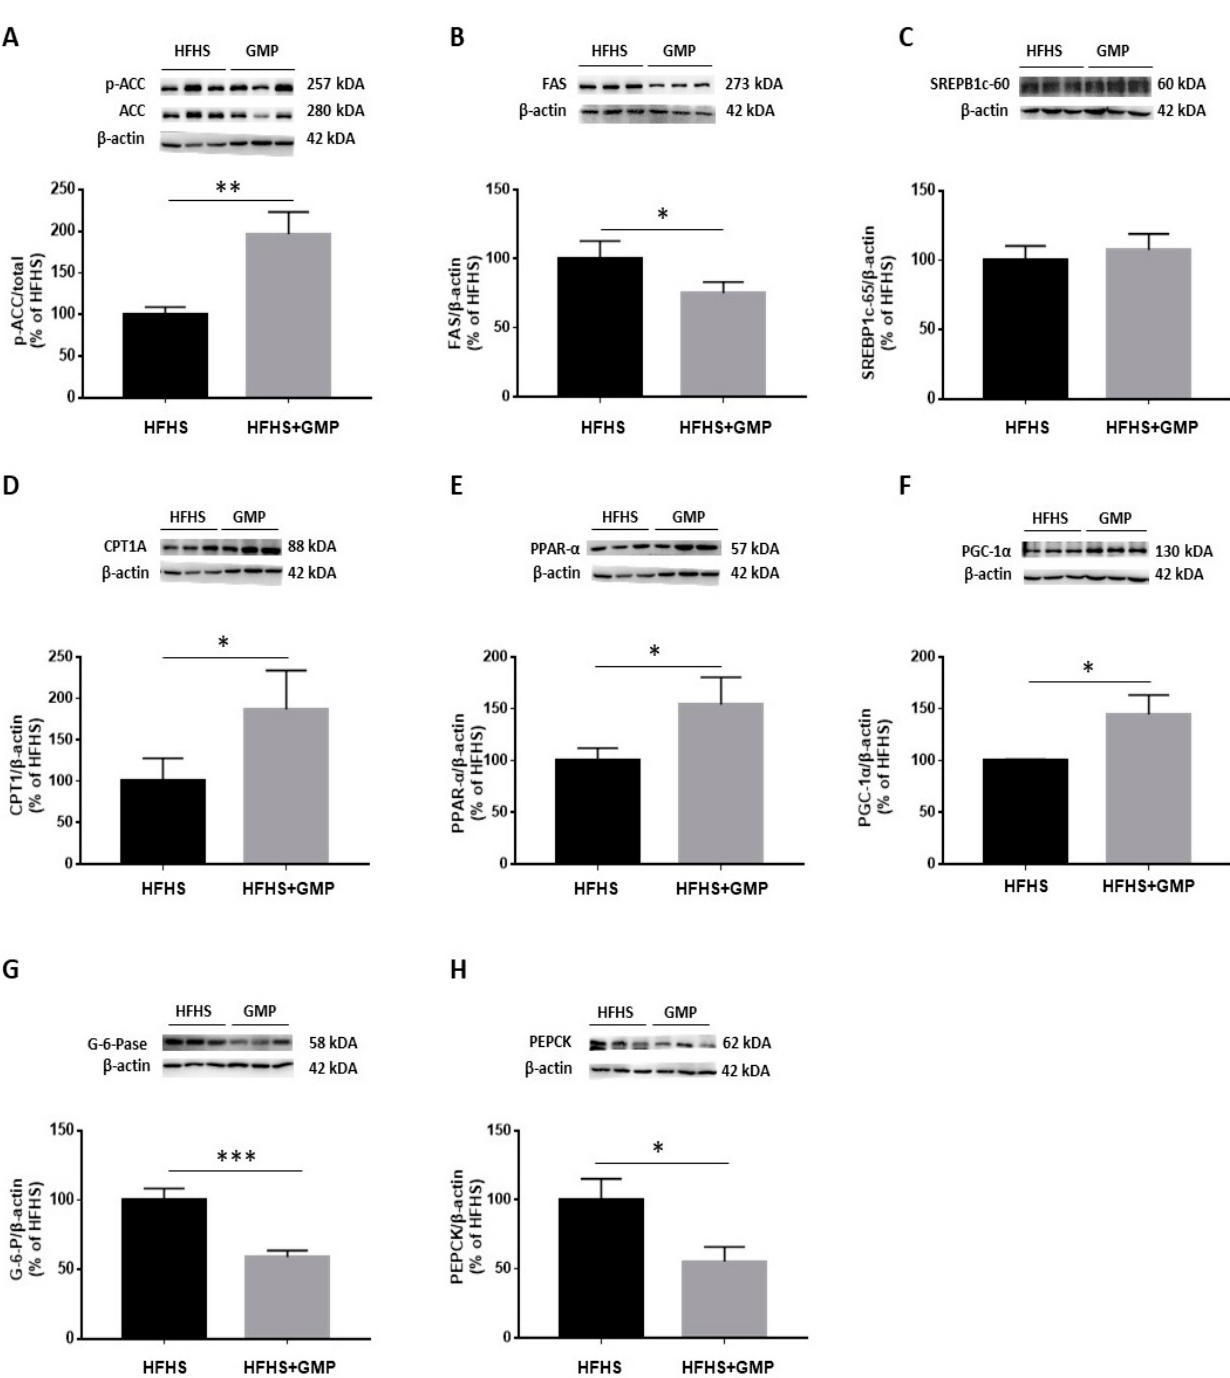
Figure 5. GMP modulates lipid and glucose metabolism in liver. ( A ) p-ACC/ACC ratio was calculated after analysis of protein expression of ACC and p-ACC, as well as ( B ) FAS, ( C ) SREBP1c, ( D ) CPT1A, ( E ) PPAR- α , ( F ) PGC-1 α , ( G ) G-6-Pase and ( H ) PEPCK by Western blot. Data are expressed as the mean ± SEM for n = 3–6 mice/group. * p < 0.05, ** p < 0.01, *** p < 0.001 vs. HFHS mice.